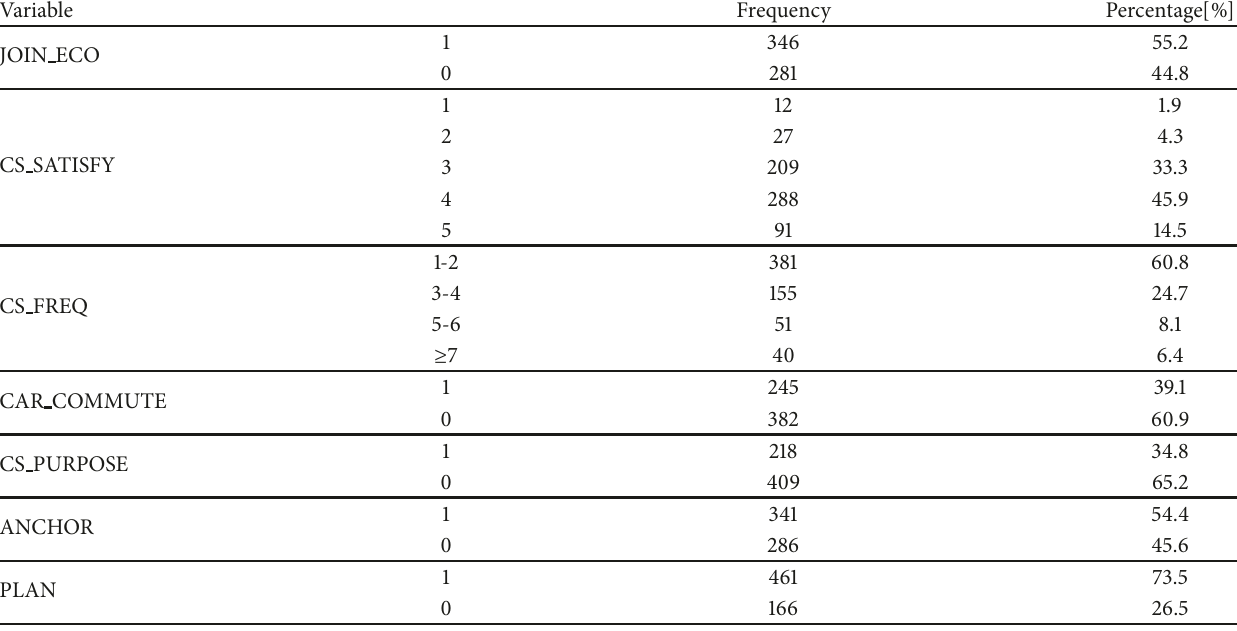
Table 11: Descriptive statistics of significant variables.